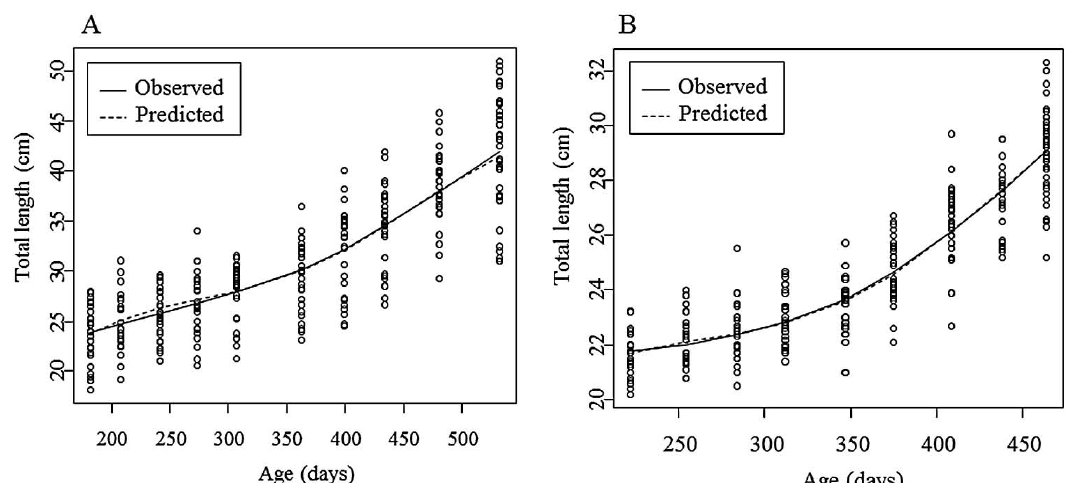
Fig. 1. – An example of the fit of the Somers’ growth model to data from two randomly selected cages. A) Total length of the fish for the first replicate of Diet B in experiment 1. B) Total length of the fish for the third replicate of Diet E in experiment 2.